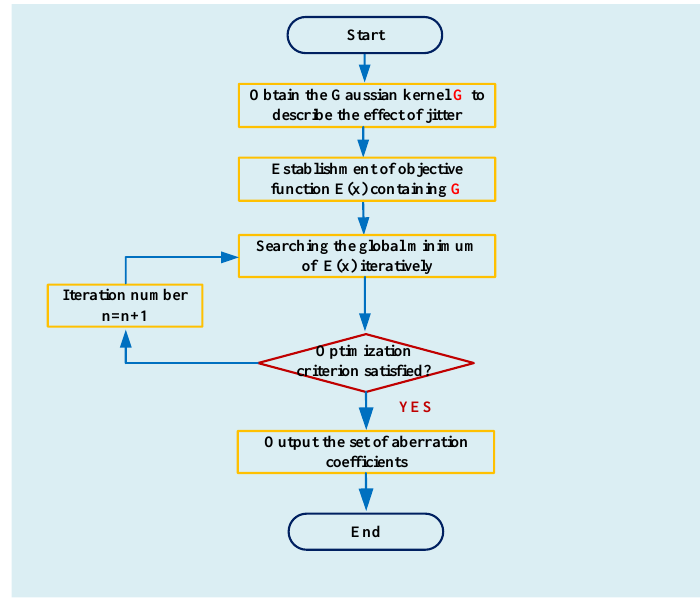
Figure 3. Diagram of parametric jitter-robust phase retrieval approach.